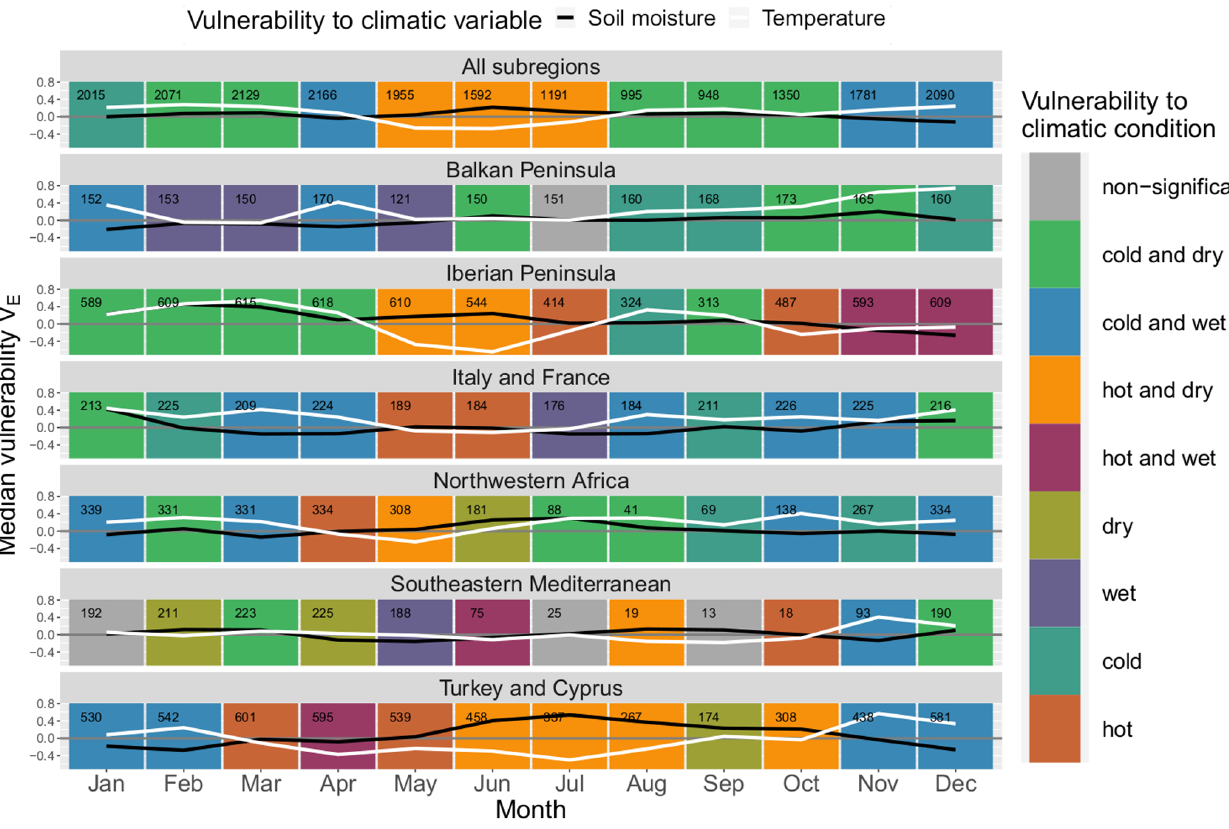
Figure A6. Median monthly ecosystem vulnerability per subregion. Vulnerability to temperature (ERA5-Land) is shown in white, and vulnerability to soil moisture (ERA5-Land at depth 28–100cm) is shown in black for each month of the year (columns) for each land cover (rows). Months with statistically significant deviation in climatic drivers during non-hazardous and hazardous ecosystem conditions according to the Mann–Whitney U test based on a significance level α = 0 . 05 are shown in colour (see legend); all other months are shown in grey. The number of grid points in which an event has occurred in this month and land cover within the period 1999–2019 is shown in the upper left corner of each